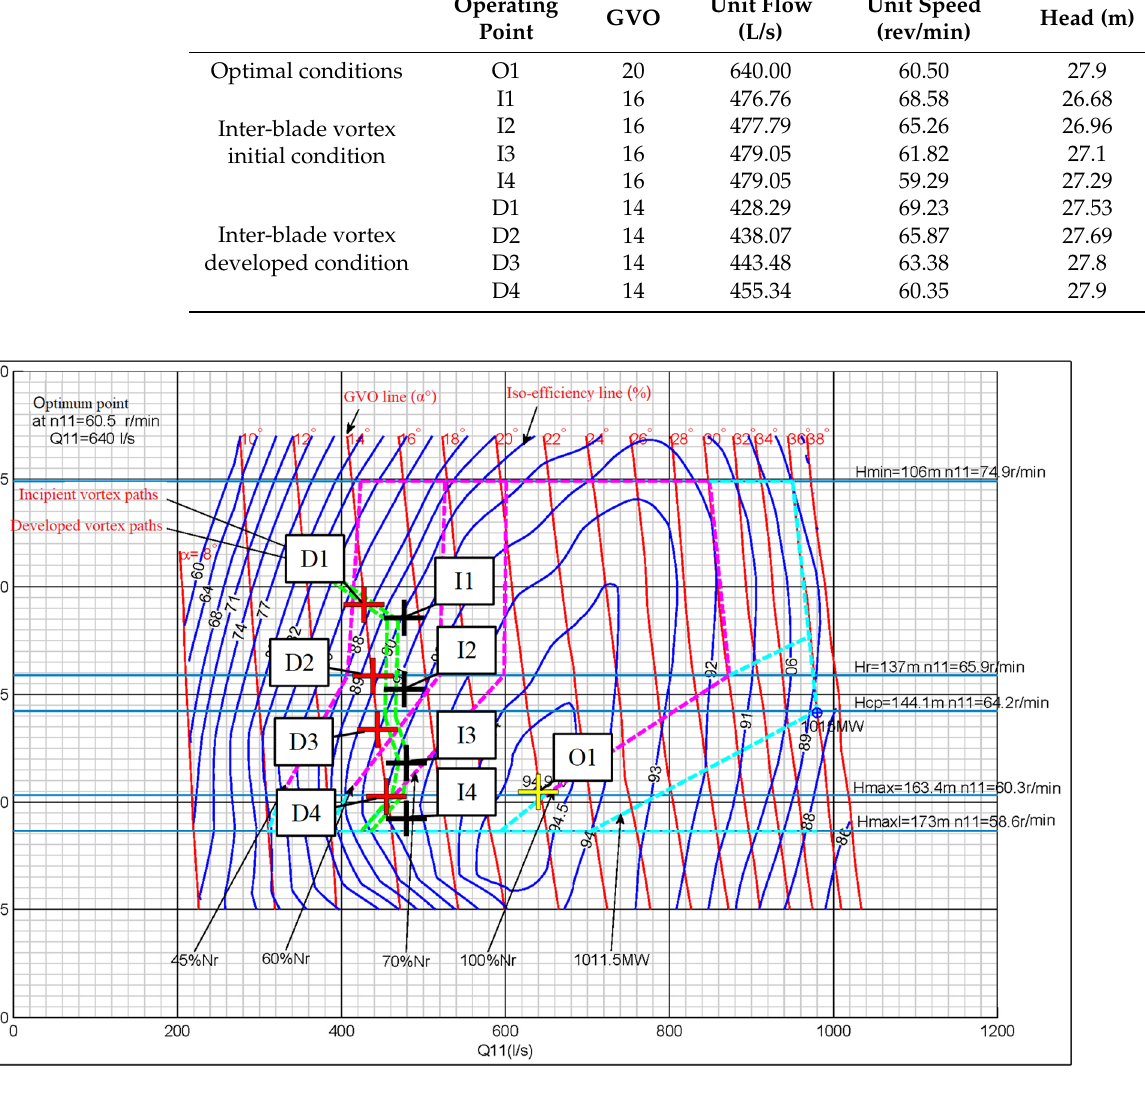
Figure 6. Distribution of operating points. D1–D4, I1–I4 and O1 is operating points in Table 3